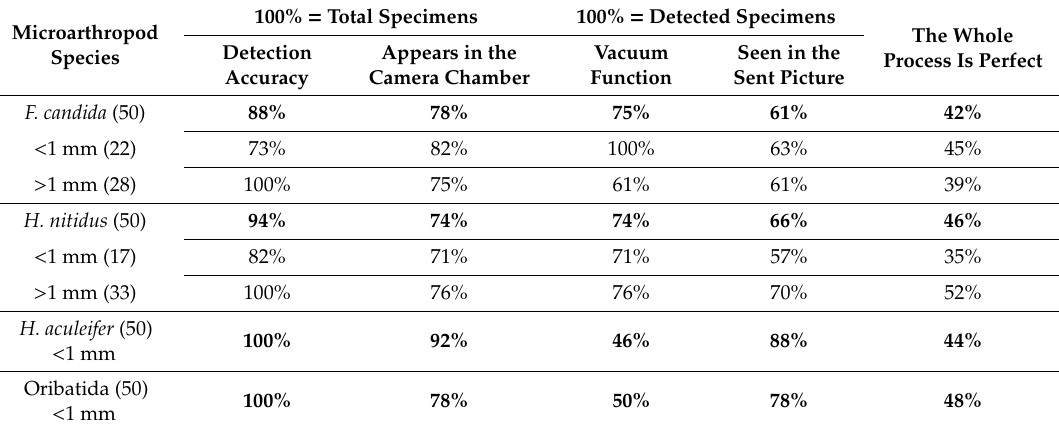
Table 1. Results of the accuracy of the desktop model. Results of the three species cultured in the laboratory are reported according to their body sizes; numbers of specimens are in brackets. Detection accuracy is defined as the mean of the number of detected specimens compared to the total specimens dropped into the probe. “Appears in the camera chamber” indicates the percent of the specimens entered into the camera chamber compared to the total number of specimens. In the next second two columns, percentages of the specimens vacuumed out and seen in the pictures are given compared to the number of detected specimens. The last column shows the percentage of the individuals which fulfilled the whole